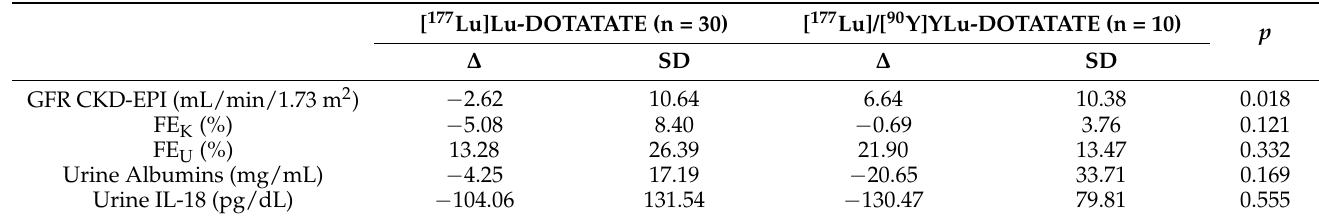
Table 4. Analysis of acute complications in patients treated with Lu vs. Lu/Y (during course